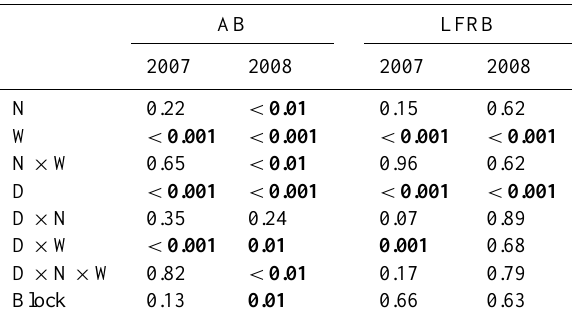
Fig. 2. Responses of aboveground biomass to water addition and nitrogen addition during the growing season in 2007 (a) and 2008 (b) . Main effects of each treatment are shown in the insets. Data are presented as mean ± SE ( n = 5). Treatments are as follows: C for control, N for nitrogen addition, W for water addition, and NW for nitrogen+water addition. Table 1. P values of repeated measures ANOVA testing for effects of nitrogen (N) and water addition (W), and sampling date (D) on aboveground biomass (AB), and live fine root biomass (LFRB) for 2007 and 2008. Significant effects ( P < 0 . 05) are indicated in